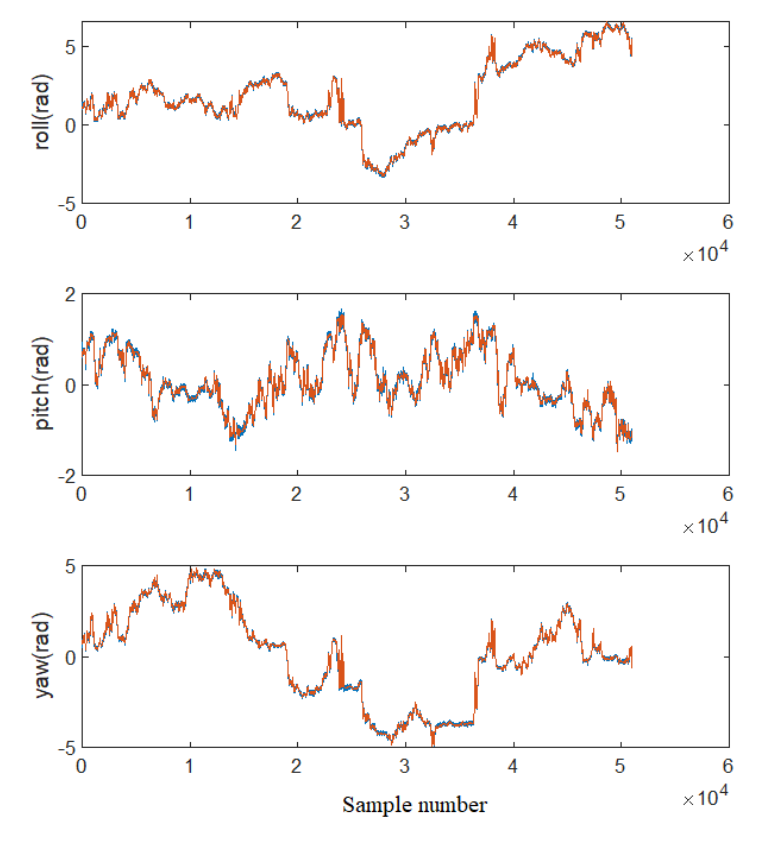
Figure 9. Estimated Euler angles of the LSTM training set: red line represents LSTM output; blue line represents sample